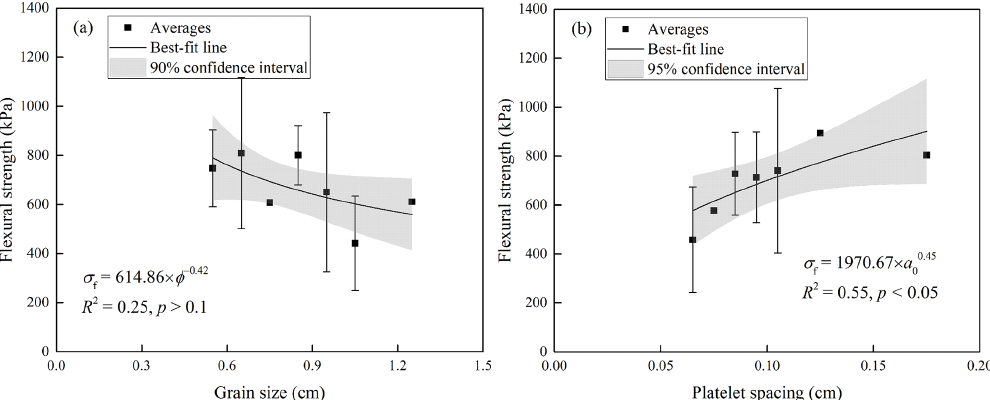
Figure 7. The variations of average flexural strength with respect to (a) grain size and (b) platelet spacing for columnar ice. Also shown are the best-fit equations, where φ and a 0 are grain size and platelet spacing,